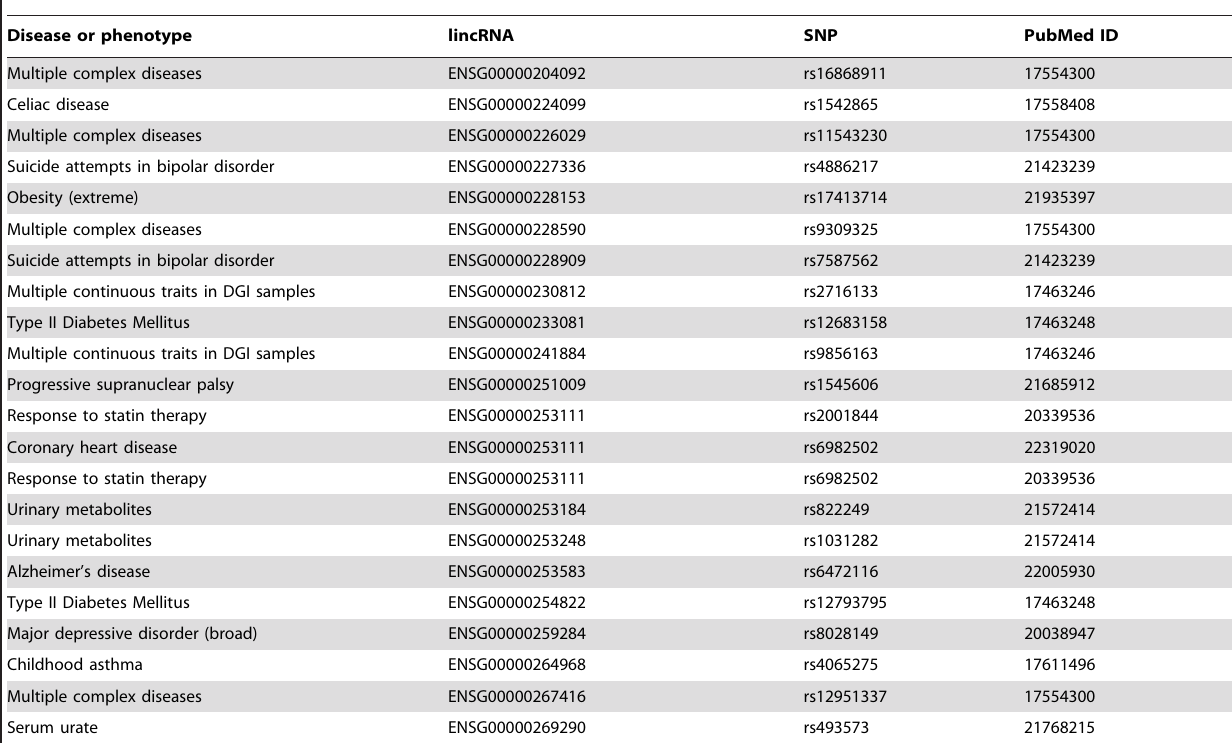
Table 1. Disease-associated SNPs in lincRNA